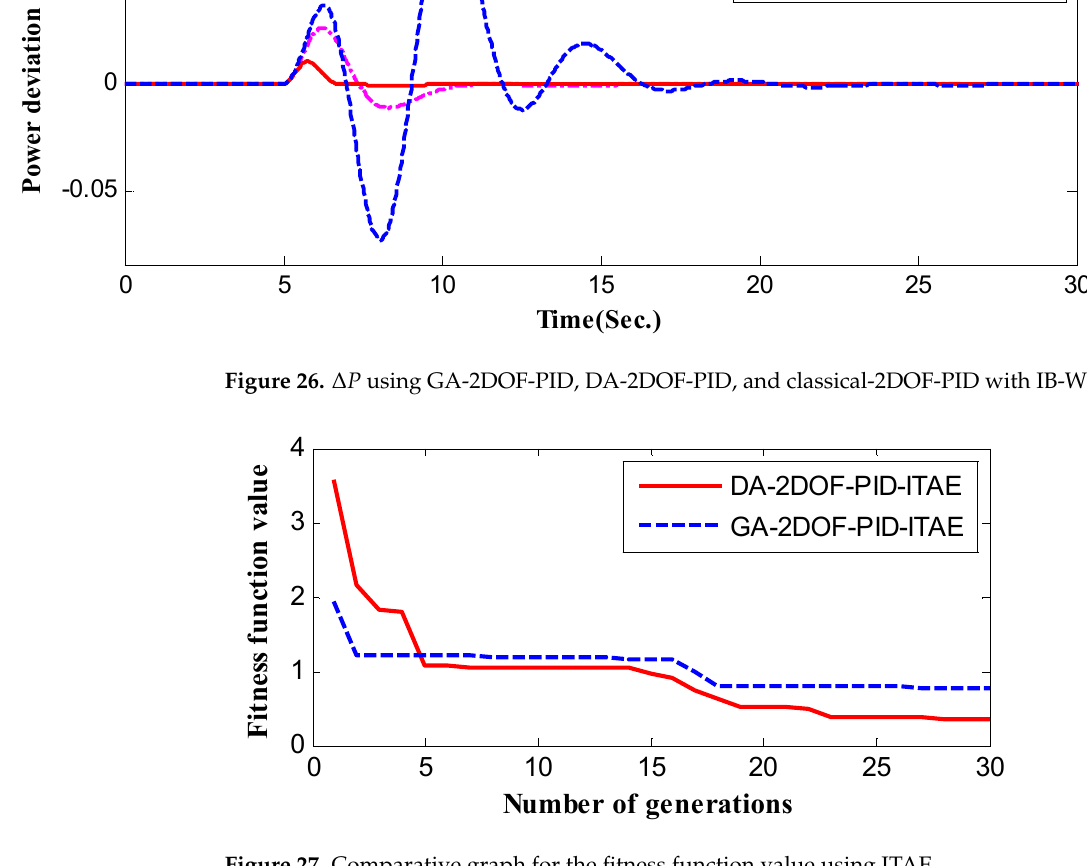
25 of 35 Figure 24. Δf (cid:2869) using GA-2DOF-PID, DA-2DOF-PID, and classical-2DOF-PID with IB-WGFF.